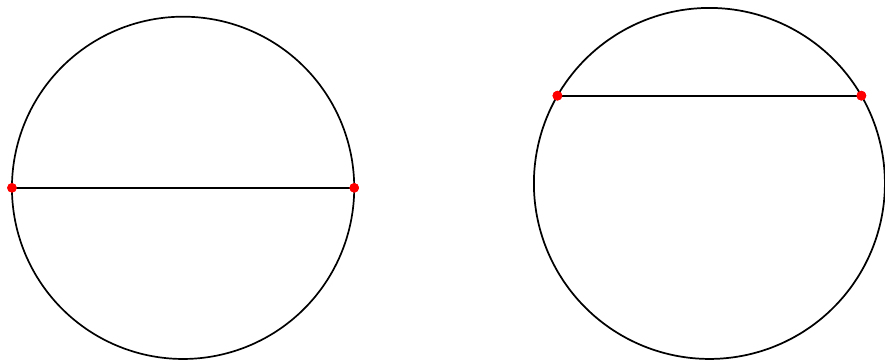
Figure 3 . Graphical representations of 0-brane solutions for k = 2 (on the left) and k = 3 (on the right). The initial 1 -brane is represented by the black line and the two solutions describing 0-branes 2 by the red points which lie on the 1 -brane. A two 0-brane solution would be represented by both of 2 the red